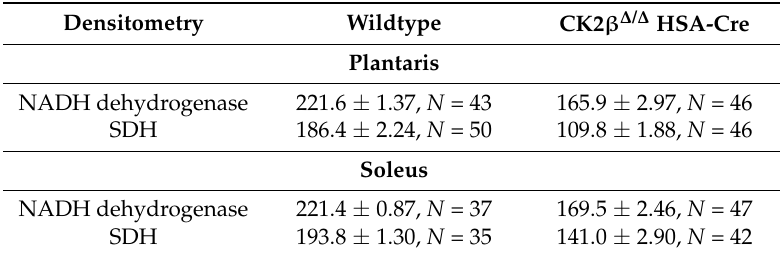
Table 1. Densitometry measurement of NADH dehydrogenase and SDH staining intensities in slow type fibers of plantaris and soleus muscle of wildtype and CK2 β -deficient